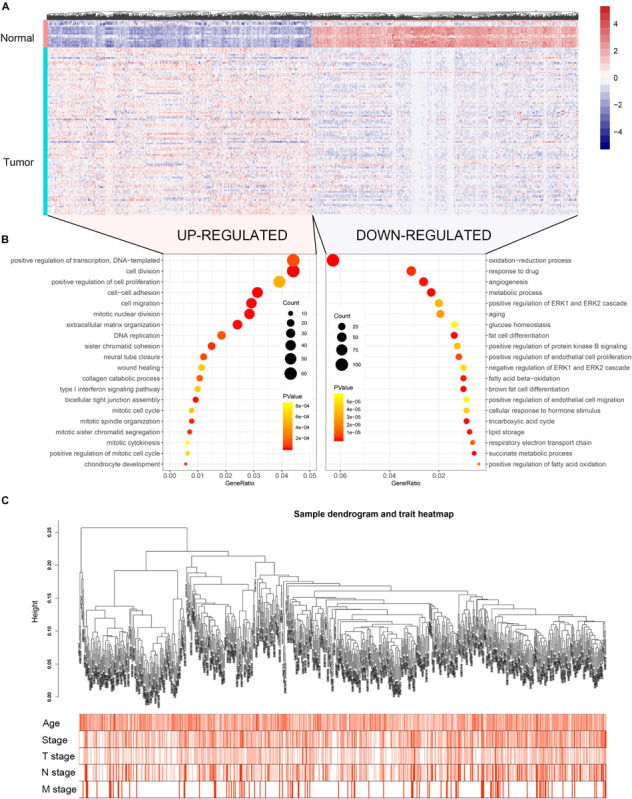
Heatmap of the DEGs, GO functional annotation and clustering dendrogram of 683 tumor samples. (A) The heatmap shows the DEGs between 104 BC and 17 normal breast samples based on the dataset GSE42568. (B) The bubble plot shows the enriched biological processes of the upregulated genes and downregulated genes. (C) The clustering of 683 BC samples based on all DEGs expression and clinical features. The color intensity represents older age and higher stage.